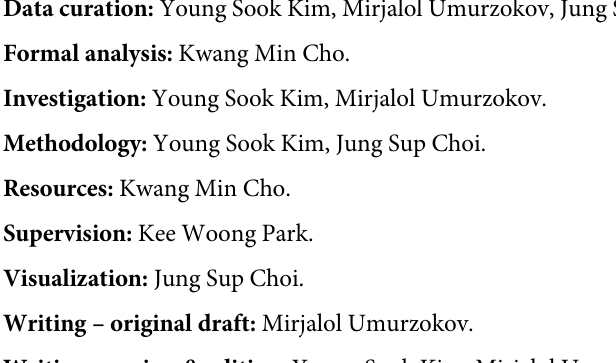
S1 Table. Insecticidal activity of the biological control agent (Bacillus thuringiensis) and chemical insecticide (Diflubenzuron) against Plutella xylostella larvae. To estimate the lar- vicidal activity, Chinese cabbage leaf disks (diameter 3 cm) were dipped for 30 seconds in the recommended concentration of insecticide solutions. Once the leaf disks were surface-dried they were inoculated with P . xylostella 2 nd instars (10 larvae/disk). Distilled water was used as untreated control. Letters in each column indicate significant differences in the Fisher’s LSD test (P <